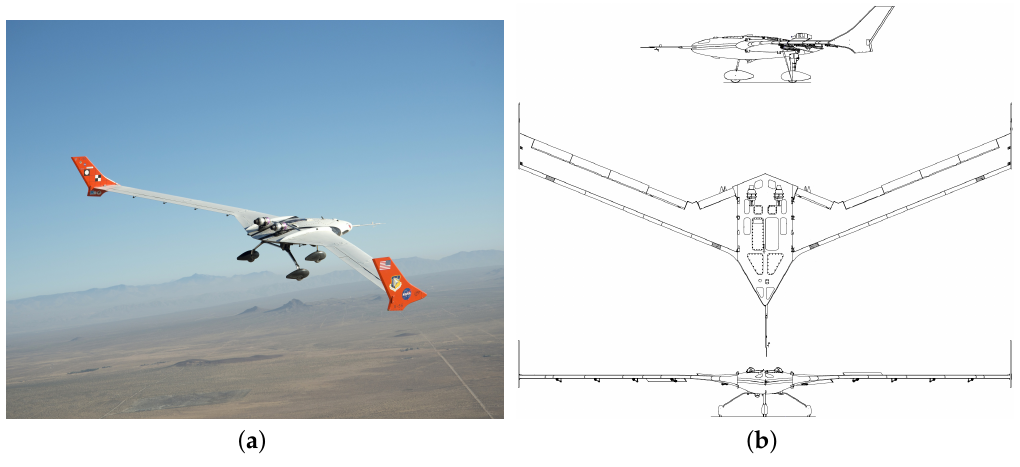
Figure 1. The X-56A MUTT subscale aeroelastic demonstrator: ( a ) airplane in flight over NASA Armstrong Flight Research Center (credit: NASA/Jim Ross); and ( b ) three-view drawing